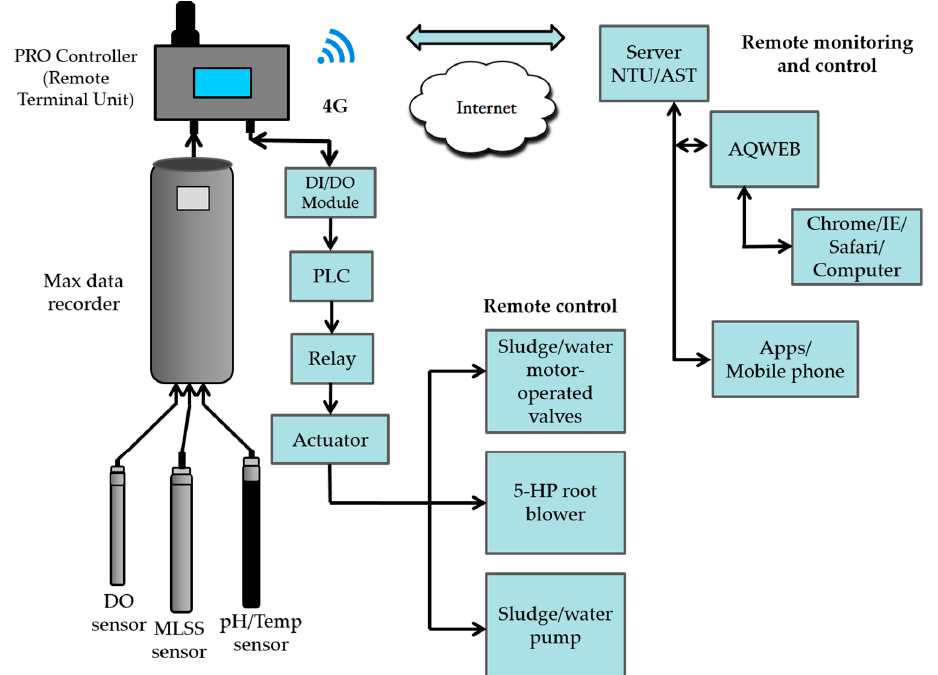
Figure 5. The diagram of smart monitoring and control in the SBR basin.